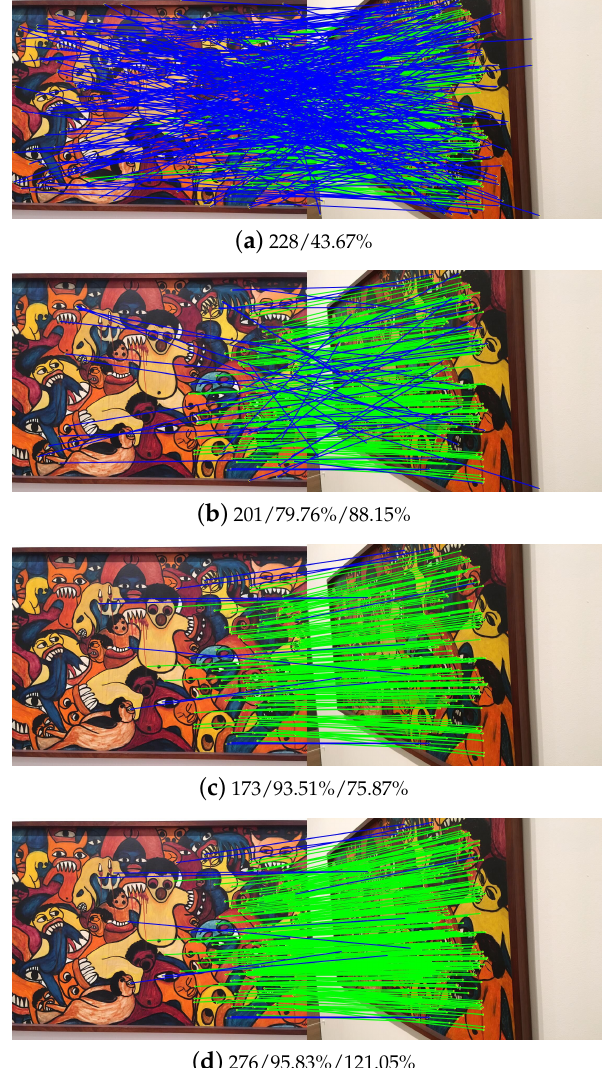
Figure 11. Image matching of one rigid pair from dataset 2. The values in sub-title ( a ) indicate the number of initial matches and its precision; the values in other sub-titles indicate the number of refined matches and its precision and